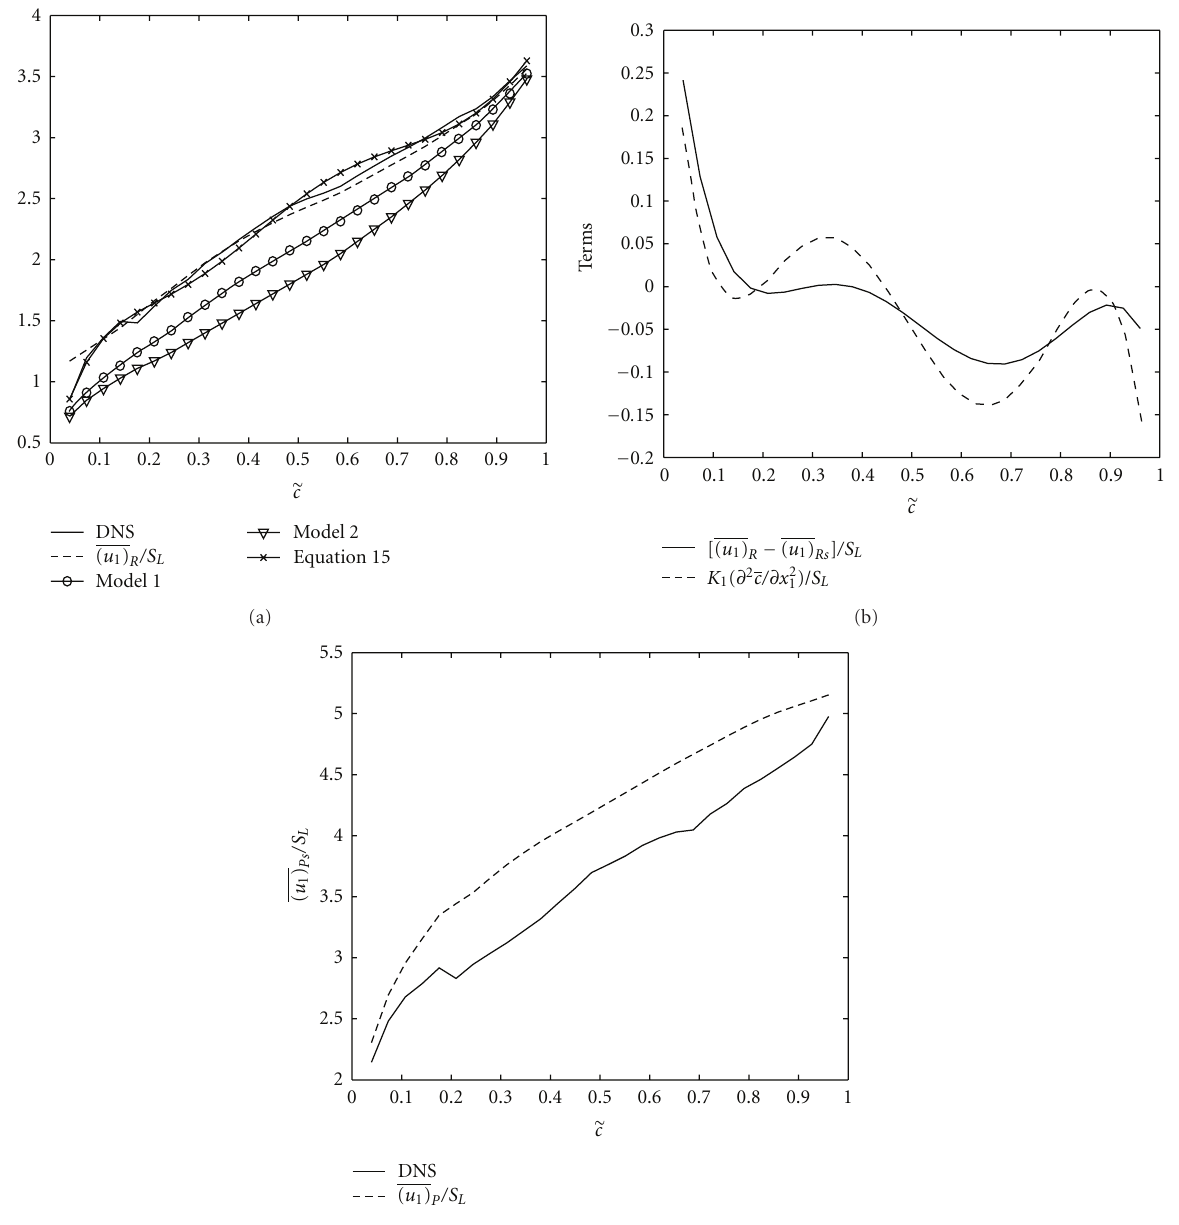
− ( u 1 ) Rs ] /S L and R